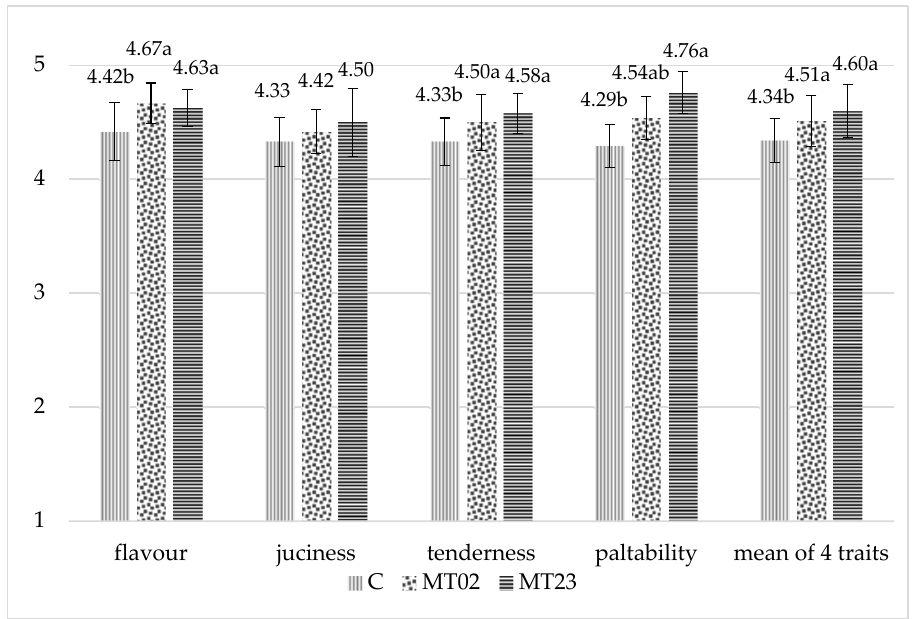
Figure 1. Sensory evaluation of breast muscles (point). C—control, MT02—milk thistle (0%/2%—starter/grower), MT23—milk thistle (2%/3%—starter/grower), SEM—standard error of mean, n = 8, a,b—means with different superscripts within a row are significantly different at p ≤ 0.05.